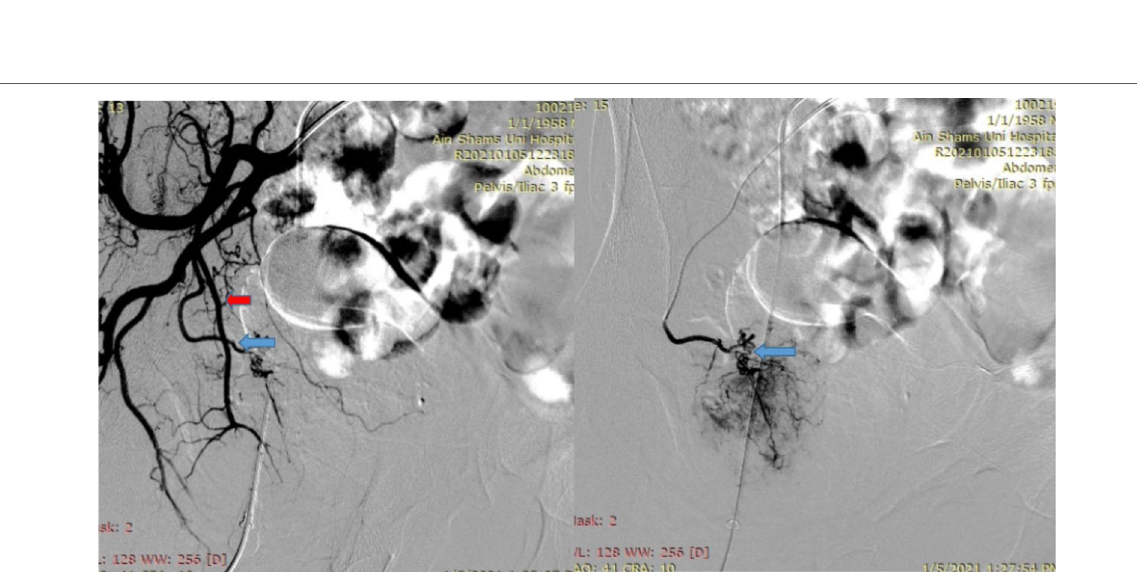
division of IIA (type III) (Fig. 10) and left side prostatic artery arising as common trunk with superior vesical artery (type I) (Fig. 11); in this case, we can see images showing that we used coils to occlude the left superior vesical artery supplying the urinary bladder to avoid non- target embolization of the urinary bladder and safely embolize the prostate (Fig. 12). And also anastomosis